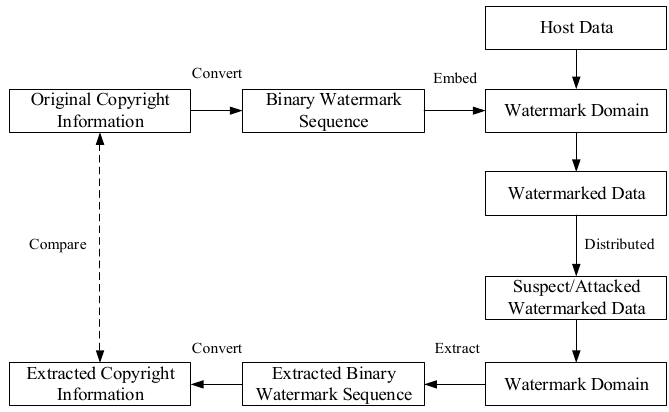
Figure 2. Watermarking procedure.